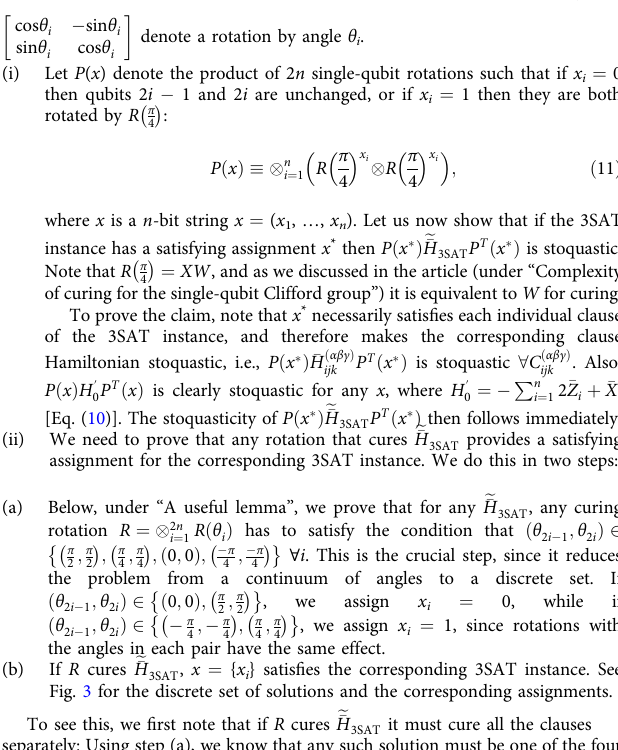
Fig. 3 for the discrete set of solutions and the corresponding assignments.